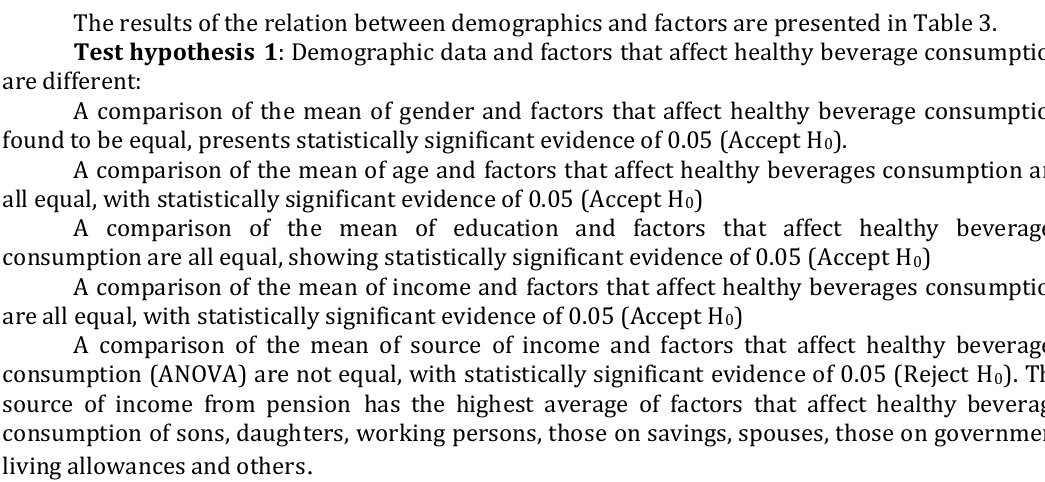
Table 3: The results of comparison of the mean of two sets of data are as follows: Sum of Square